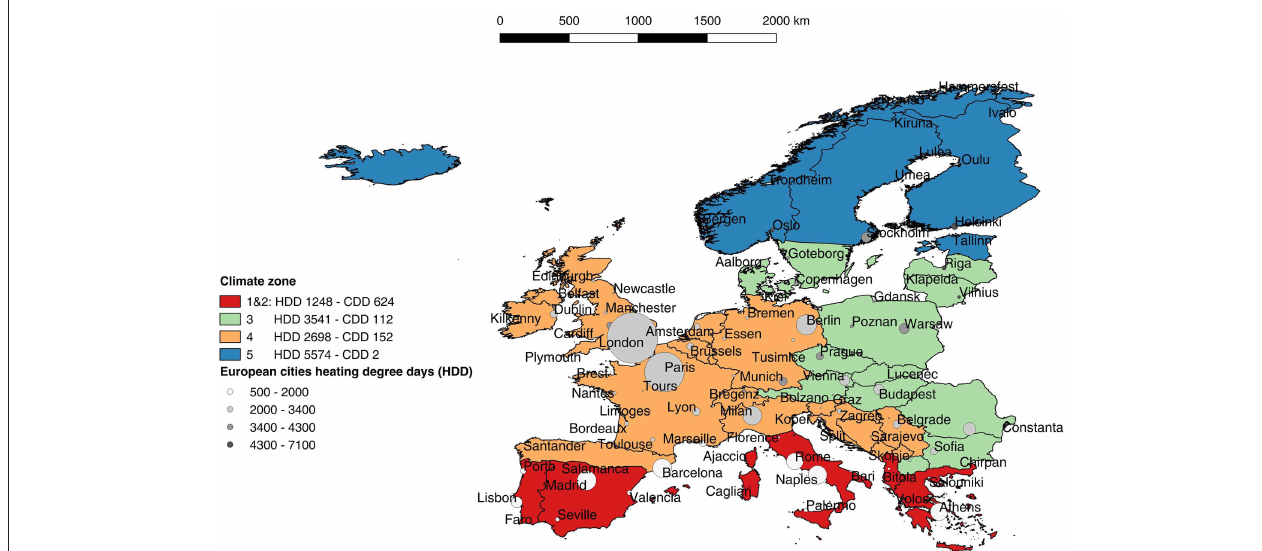
FIGURE 2 | European climate